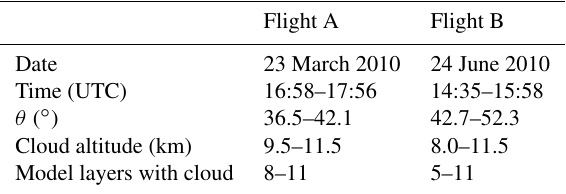
Table 2. Flight information. θ is the solar zenith angle during the flights A and B.